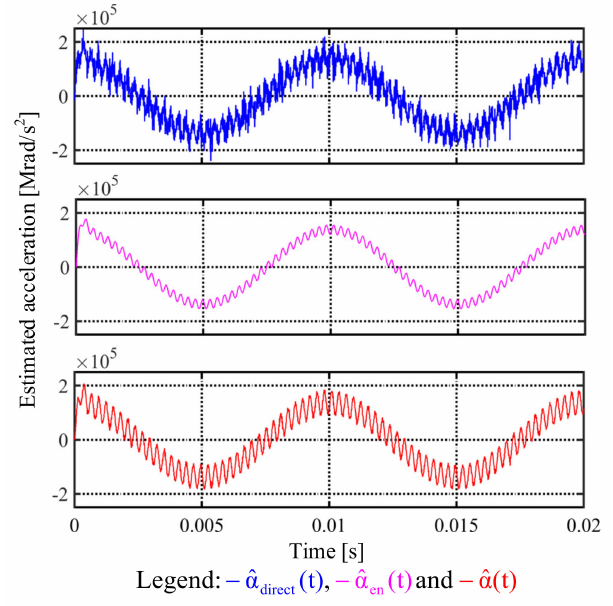
Figure 15. Simulation of different acceleration estimations under a sinusoidal position feedback signal (0.002% white noise).